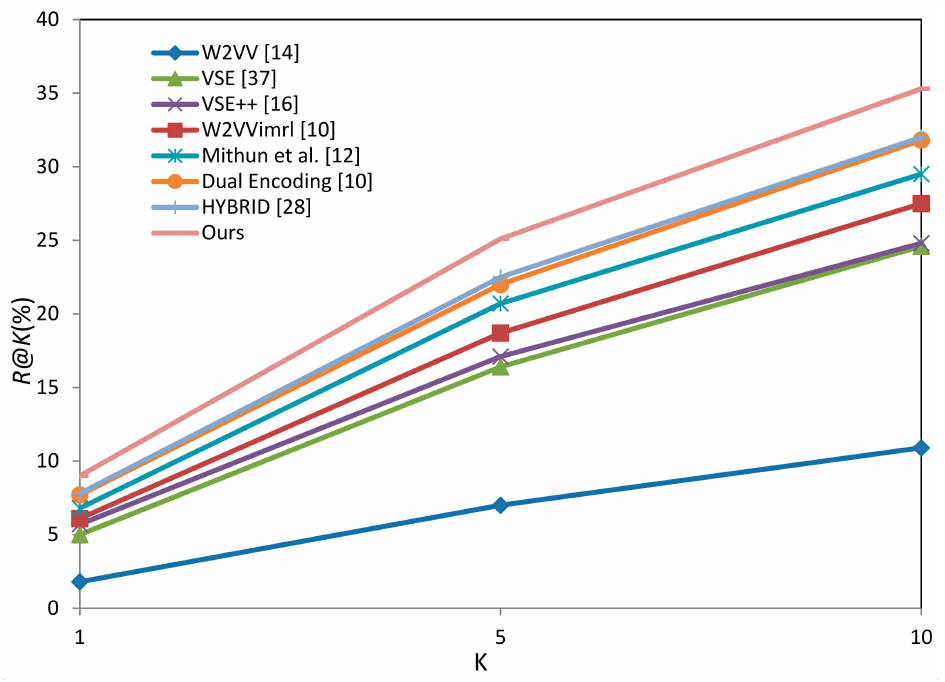
Figure 5. Trend curves of R @ K in the MSR-VTT